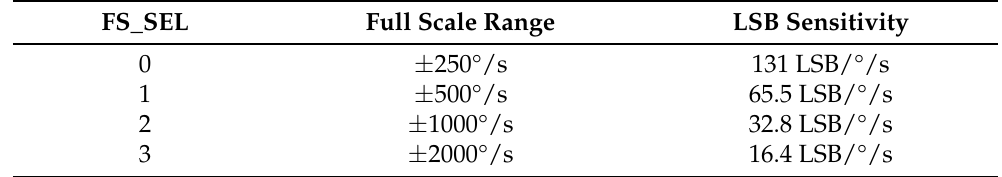
Table A1. Gyroscope